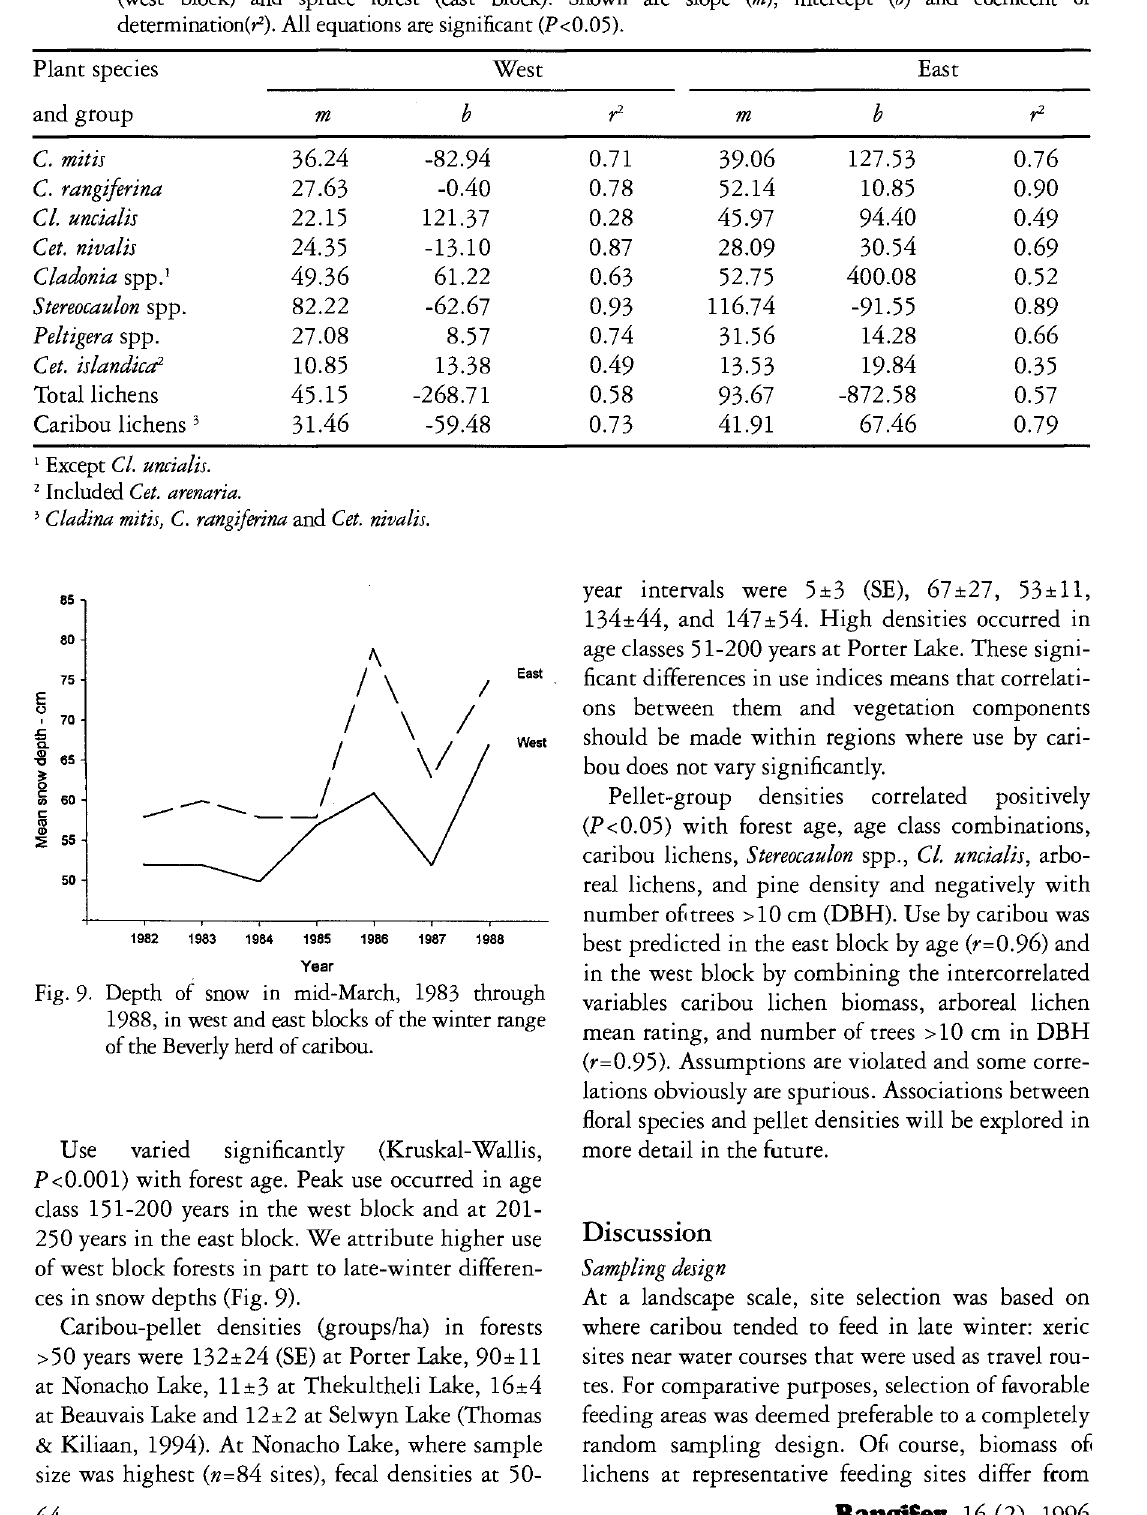
Table 5. Regression variables used ro predict biomass from cover of lichen species and groups in pine-spruce forest (west block) and spruce forest (east block). Shown are slope (m), intercept (b) and coefficent of determination^). All equations are significant (P<0.05).